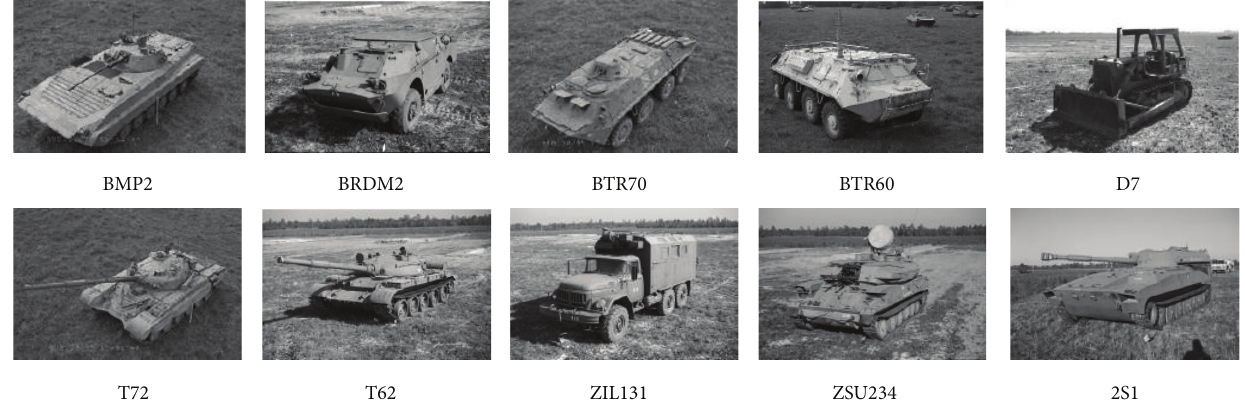
Figure 4: Visible light images for 10-target in MSTAR